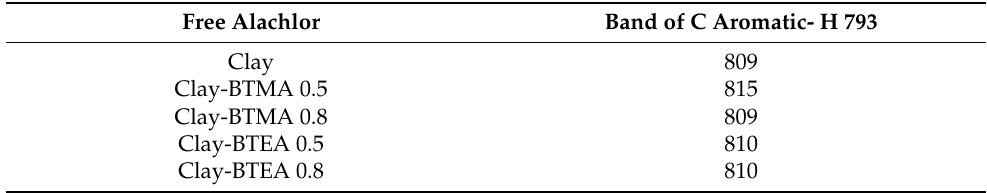
Table 1. FTIR vibration bands (cm − 1 ) of Alachlor and Alachlor sorbed on Montmorillonite and its complexes